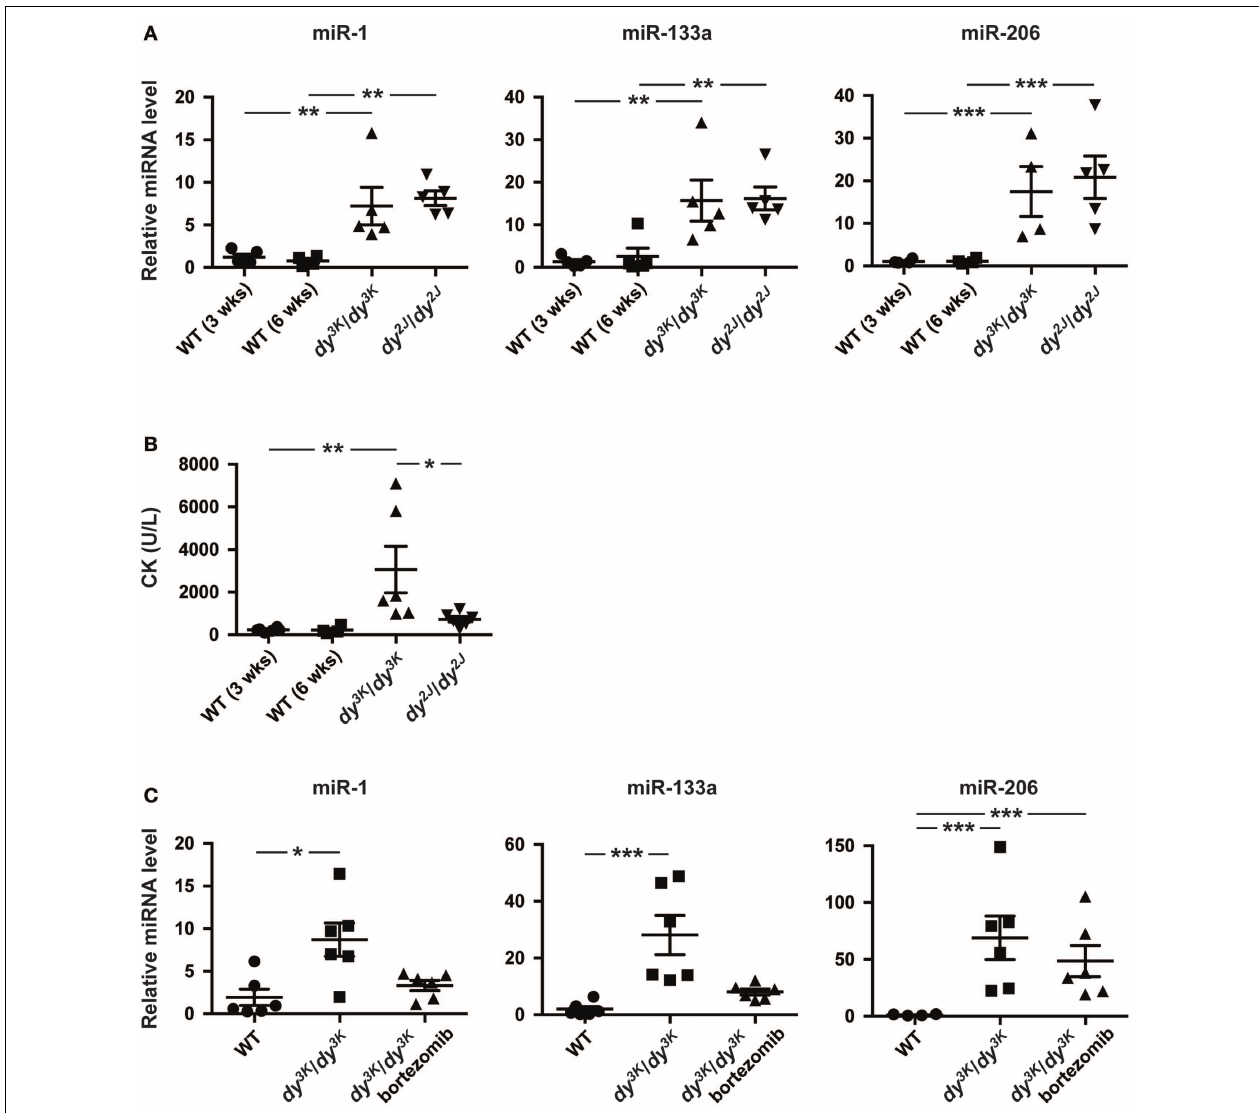
( n ≥ 4). (C) RT-qPCR analysis of plasma levels of indicated miRNAs inWT, dy 3K /dy 3K , and bortezomib injected dy 3K /dy 3K mice ( n ≥ 4).WT, wild-type; CK, creatine kinase. Error bars represent SEM, * P < 0.05, ** P < 0.01, *** P <